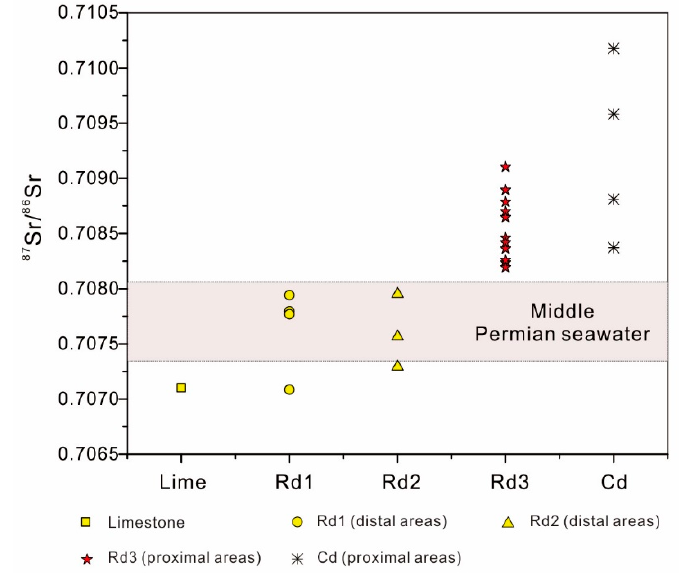
Figure 14. 87 Sr/ 86 Sr ratios of limestone, replacive dolomites (Rd1–Rd3), and cement dolomite (Cd). The shaded area represents estimated 87 Sr/ 86 Sr ratios of Middle Permian seawater (0.7074–0.7081) [47].